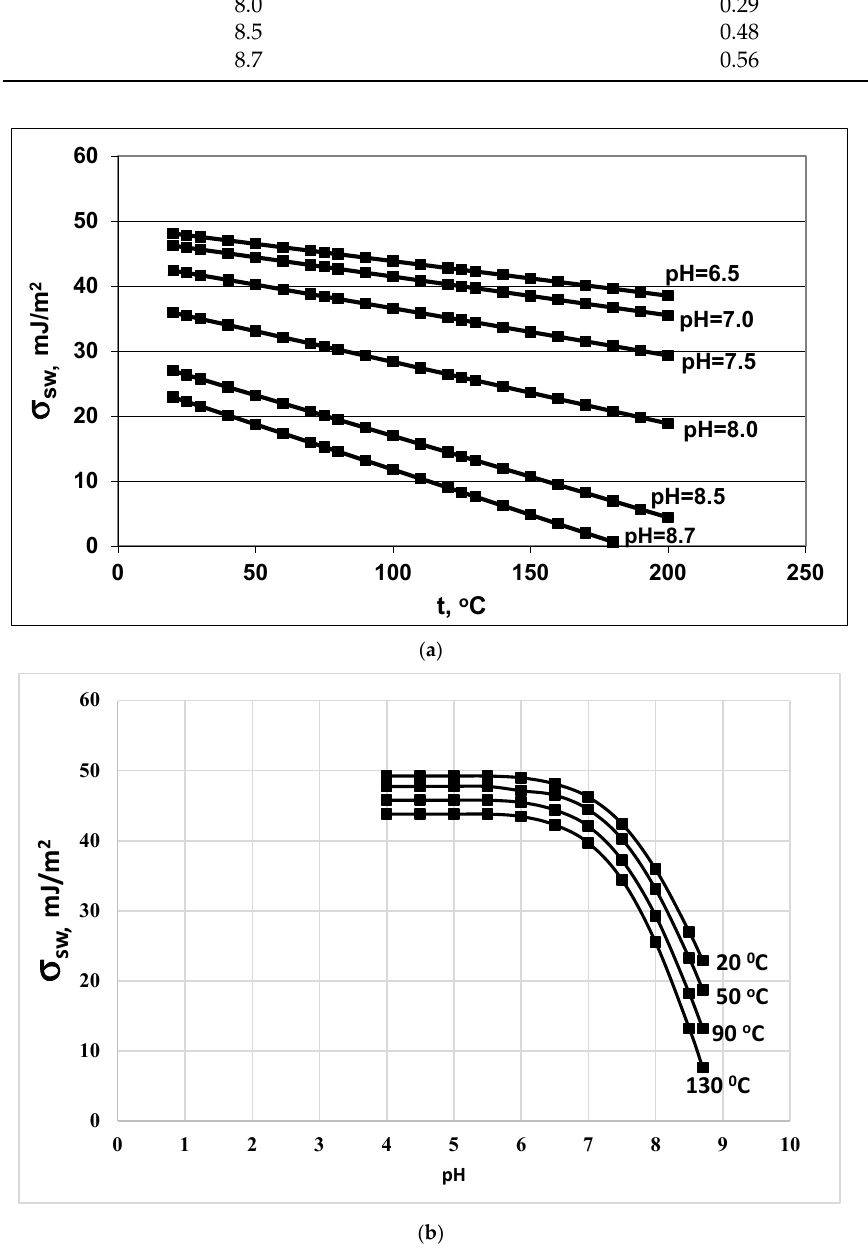
Figure 3. Dependence of the surface tension σ sw (mJ/m 2 ) on a) temperature t (°C) and b) on pH. Initial concentration С s = 700 mg/kg. The physical meaning of the Zeldovich factor Z, calculated using Equation (9), is that only a certain proportion of particles whose sizes have reached a critical radius continue to grow further. The remaining particles decrease in size. At the same time, the concen- tration of particles whose sizes are higher than the critical radius is less than the equilib-